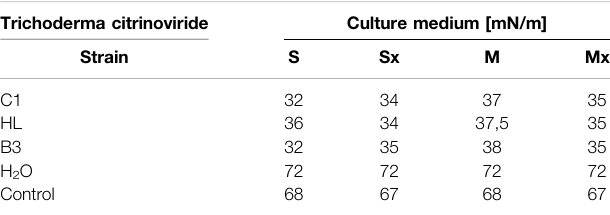
TABLE 1 | Surface tension measurements (mN/m) in post-culture fl uid, (M) MGP medium, (S) Saunders medium, (Mx) MGP medium with inductors, (Sx) Saunders medium with